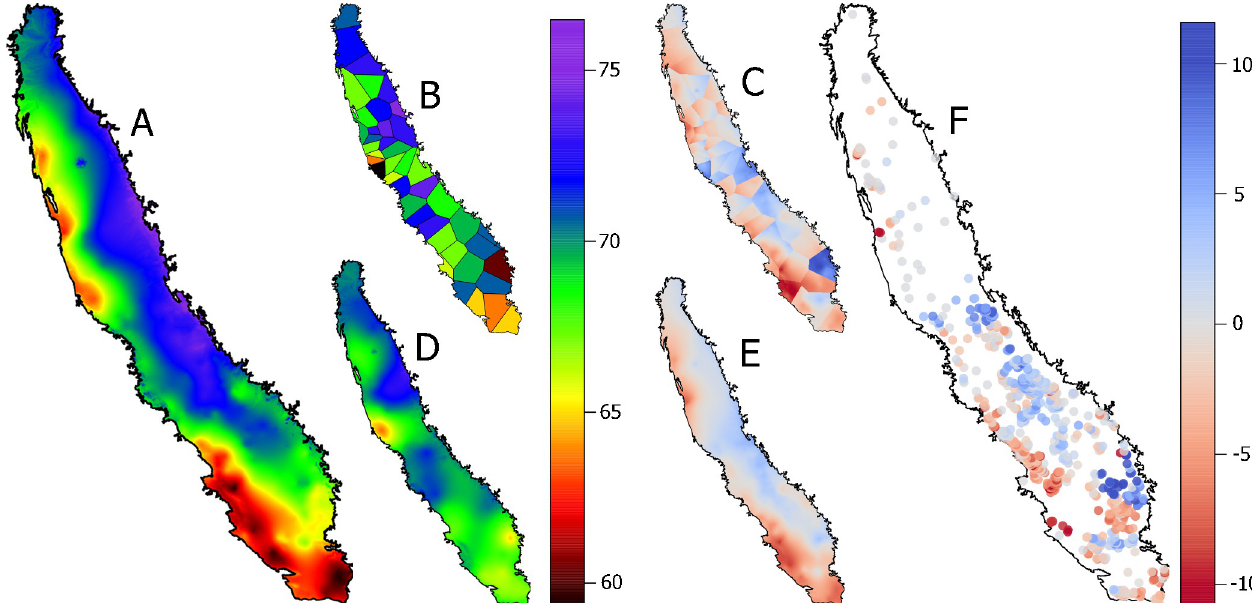
Fig 4. Chill accumulation (chill portions) interpolated using CIMIS and 731 in-orchard stations (A), GDD Tb0 accumulation for the closest CIMIS station (B), discrepancy between interpolation and closest CIMIS (C), chill accumulation interpolated using only CIMIS stations (D), discrepancies between interpolations using CIMIS and in-orchard stations combined and CIMIS stations only (in-orchard/CIMIS minus CIMIS value; E) and discrepancy between each of the 731 in-orchard stations and their closest CIMIS station (in-orchard/CIMIS interpolation minus closest CIMIS value; F) during the chill period